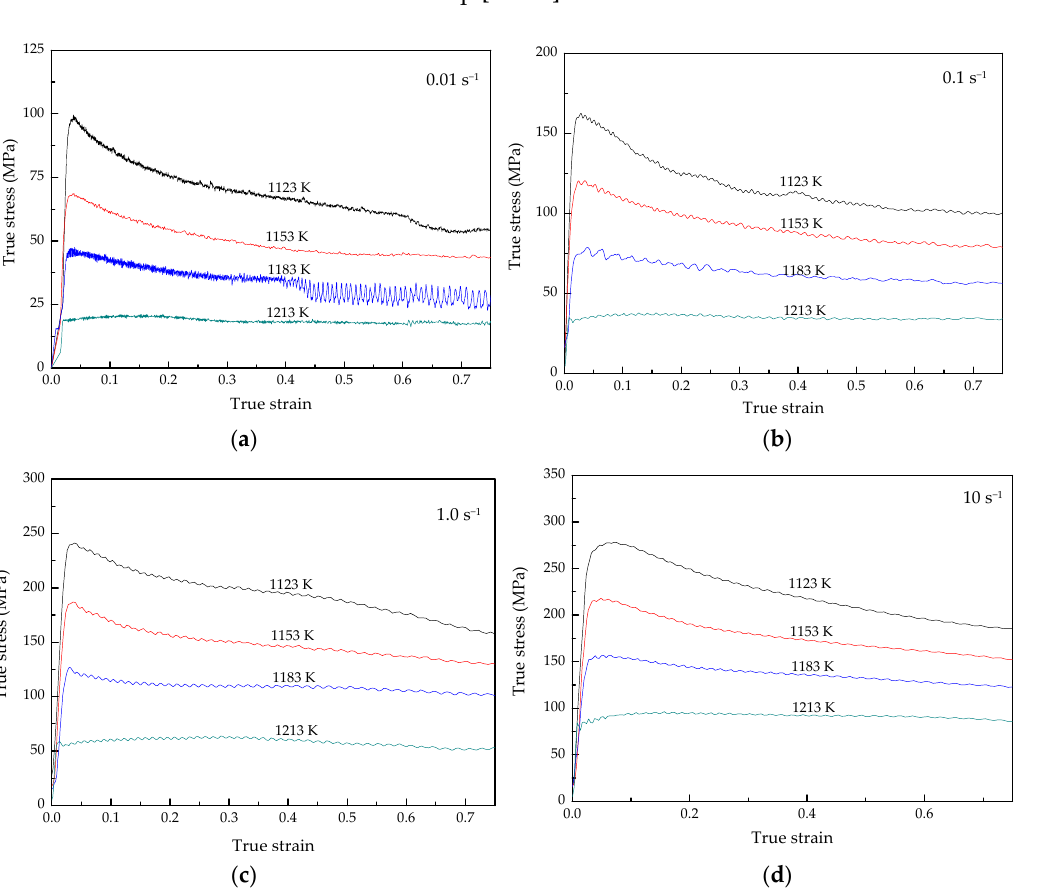
0.01 s − 1 to 10.0 s − 1 , the peak flow stress correspondingly increases from 99 MPa to 278